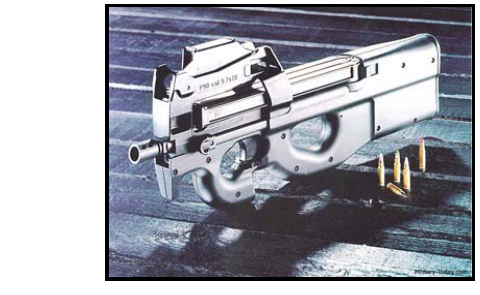
Figure 5 – FN P90 Submachine gun Рис . 5 – Автомат ФН П 90 Слика 5 – Аутомат FN